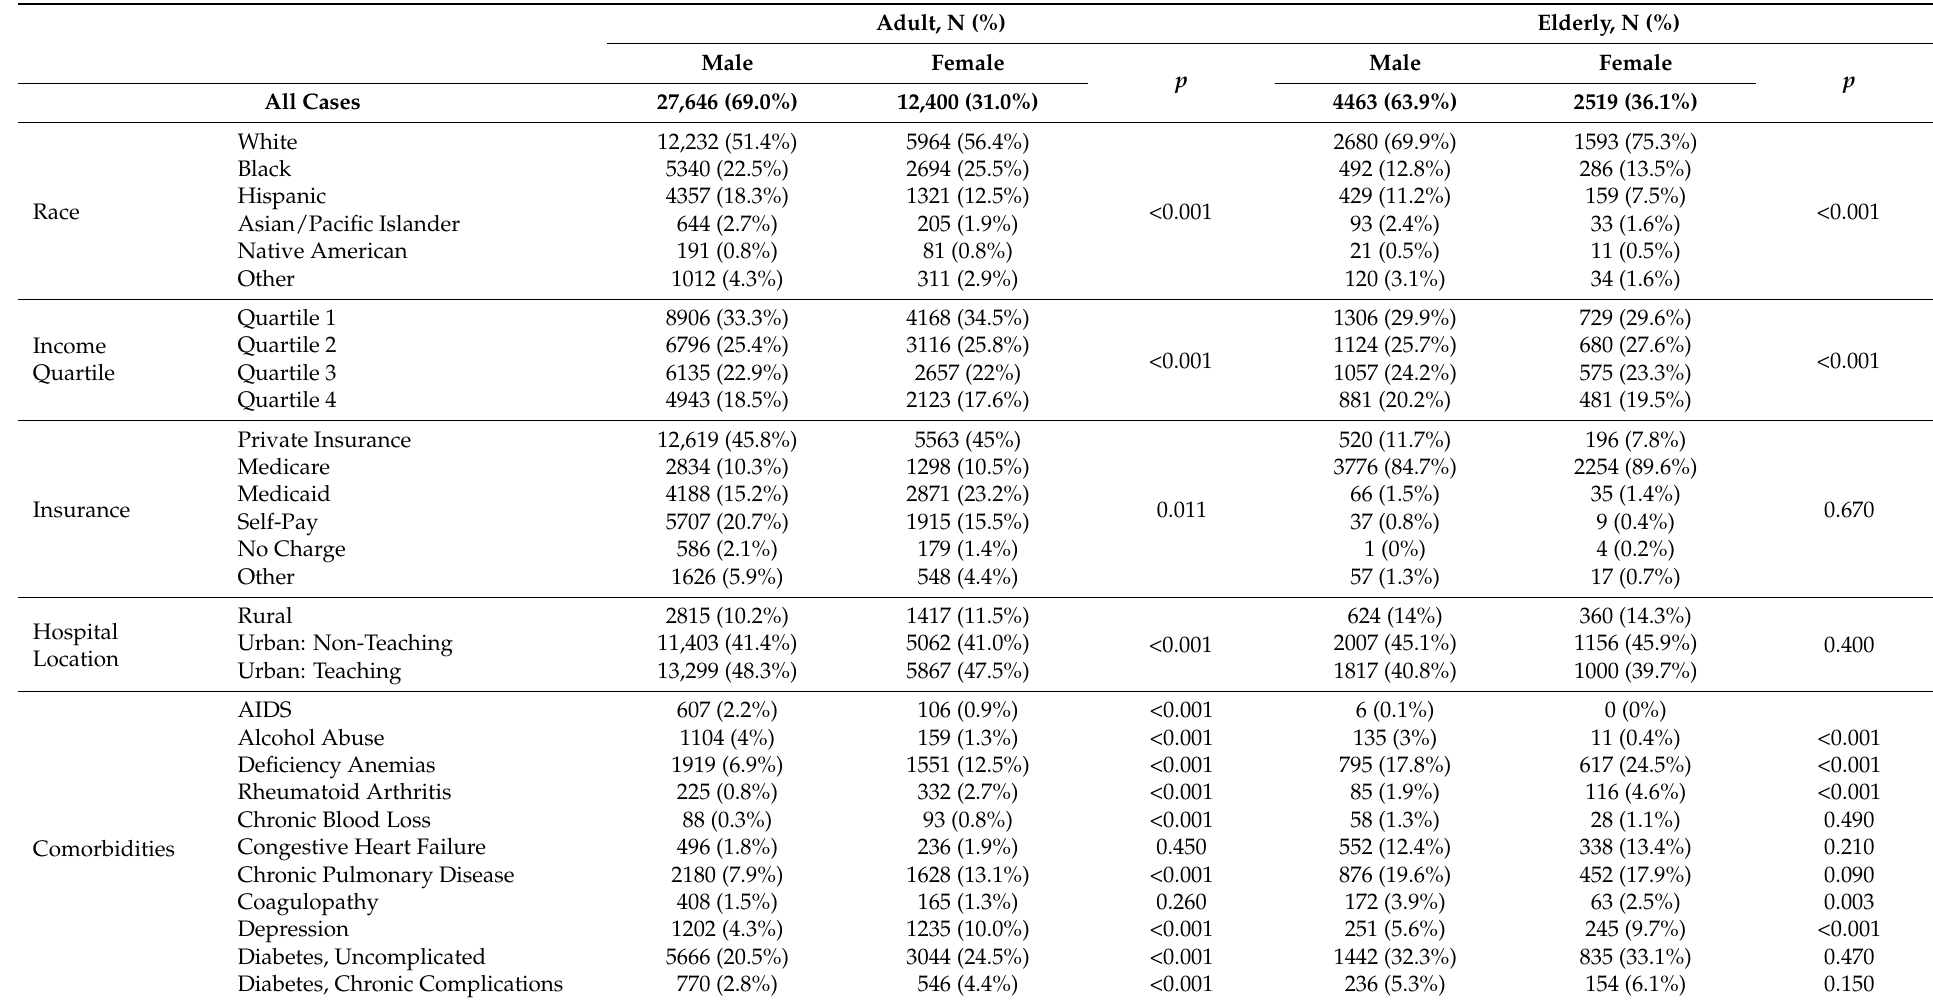
Table 1. Characteristics of emergently admitted patients with the primary diagnosis of abscess of anal/rectal regions. Data are stratified according to sex categories, NIS